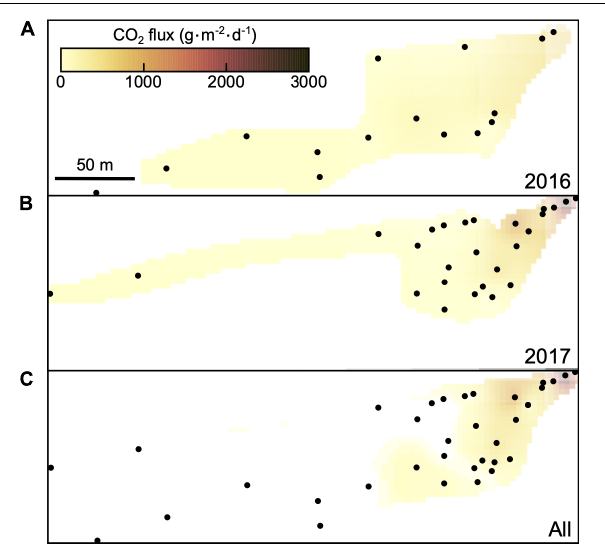
FIGURE 7 | Data from Crater J in Tarawera interpolated using simple kriging for (A) 2016, (B) 2017, and (C) all data, where black circles are the location of CO 2 flux measurements. Location within Crater J shown in Figure 6 by gray